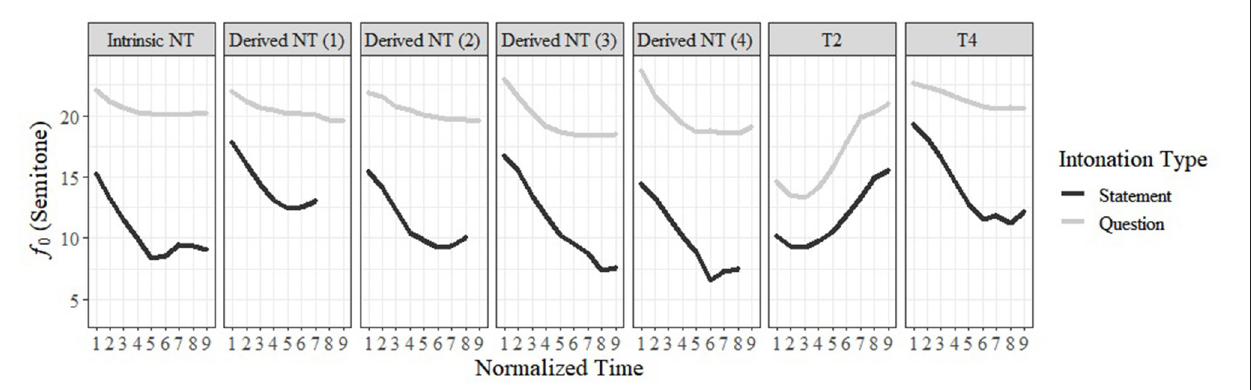
FIGURE 1 | Contours of the 2nd-syllable tone by tone and intonation (Numbers in brackets indicate the phonological tones of Derived NTs).